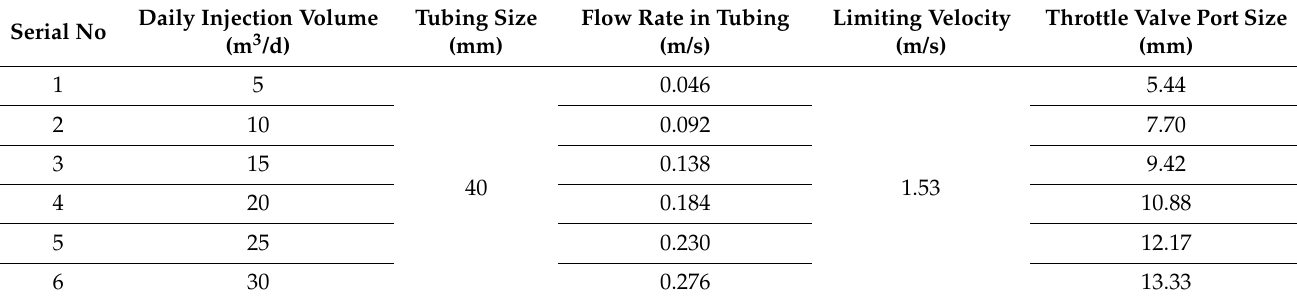
Table 2. Choke valve port size selection under low injection